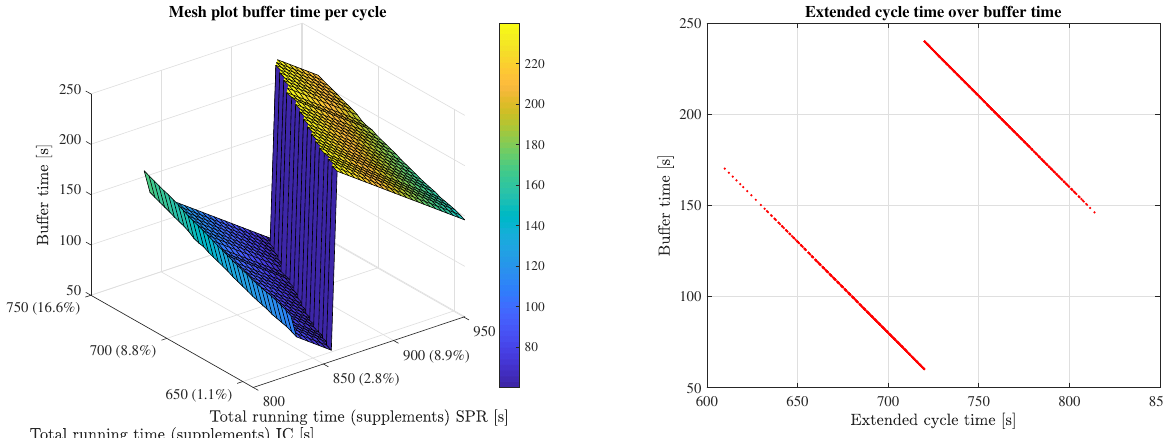
Figure 10: The left plot shows the mesh plot for the case Ah-Nm for the buffer time per cycle over the running time (supplements) of the SPR and IC. The right plot indicates the buffer time over extended cycle time for the case